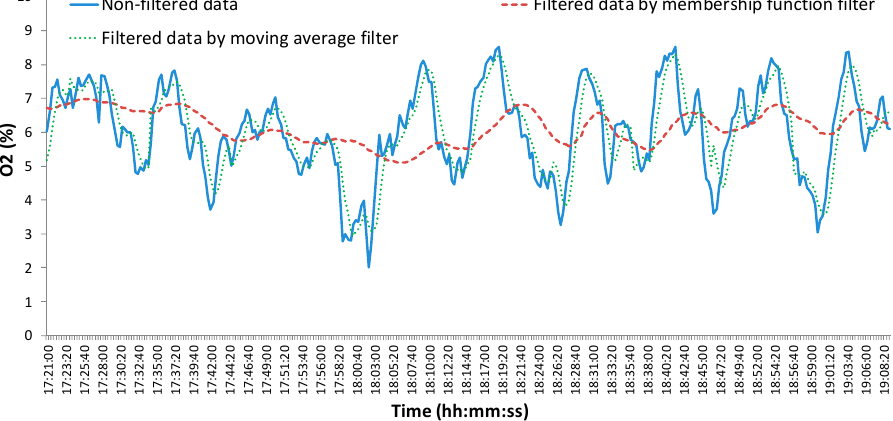
Figure 16. Comparison of membership function filter with moving average filter.